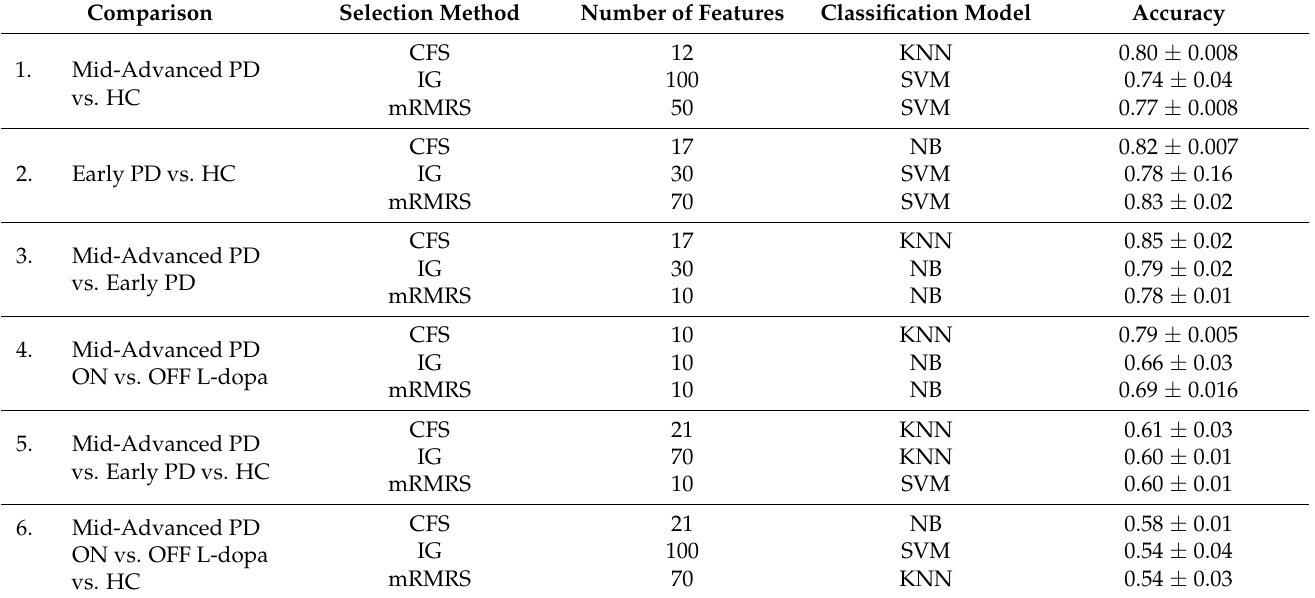
Table 3. Comparison across the three feature selection algorithms employed. For each method, we report the couple number of features–ML model that enhances the best performance, and the corre- sponding classification accuracy. Results are expressed as k-fold CV average and standard